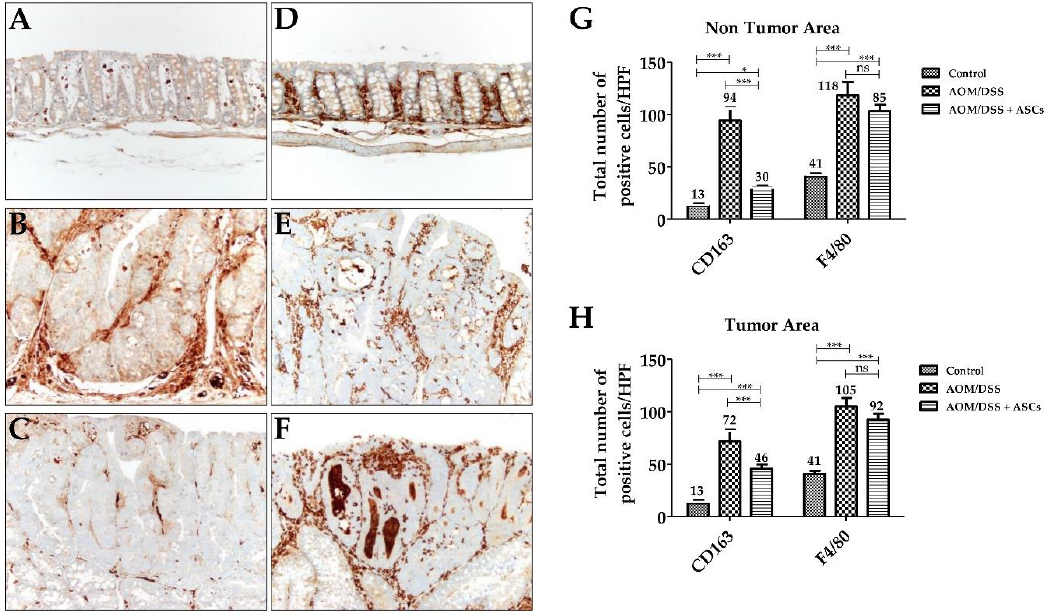
Figure 6. Changes in macrophages by TRAIL-expressing ASCs. ( A – C ) CD163 immunostaining (×200). ( A ) Normal mucosa with a few scattered CD163-positive M2 macrophages in lamina propria. ( B ) AOM/DSS-induced tumor with numerous M2 macrophages in the peritumoral area. ( C ) AOM/DSS + ASC-treated group showing a reduced number of M2 macrophages. ( D – F ) F4/80 immunostaining (×200). ( D ) Normal mucosa. Tumors from ( E ) AOM-DSS group and ( F ) AOM/DSS + ASCs group showing numerous macrophages. ( G , H ) Comparison of the number of macrophages between the three groups. There was a significantly higher number of F4/80-positive M2 macrophages in AOM/DSS-induced tumoral ( H ) and non-tumoral ( G ) mucosa than in the CD163-positive M2 macrophages. ASCs treatment significantly reduced the number of CD163-positive M2 macrophages, but not F4/80-positive M2 macrophages in the tumor and non-tumor areas. (* p < 0.05, *** p < 0.001, ns p > 0.05). ns: not statistically significant.